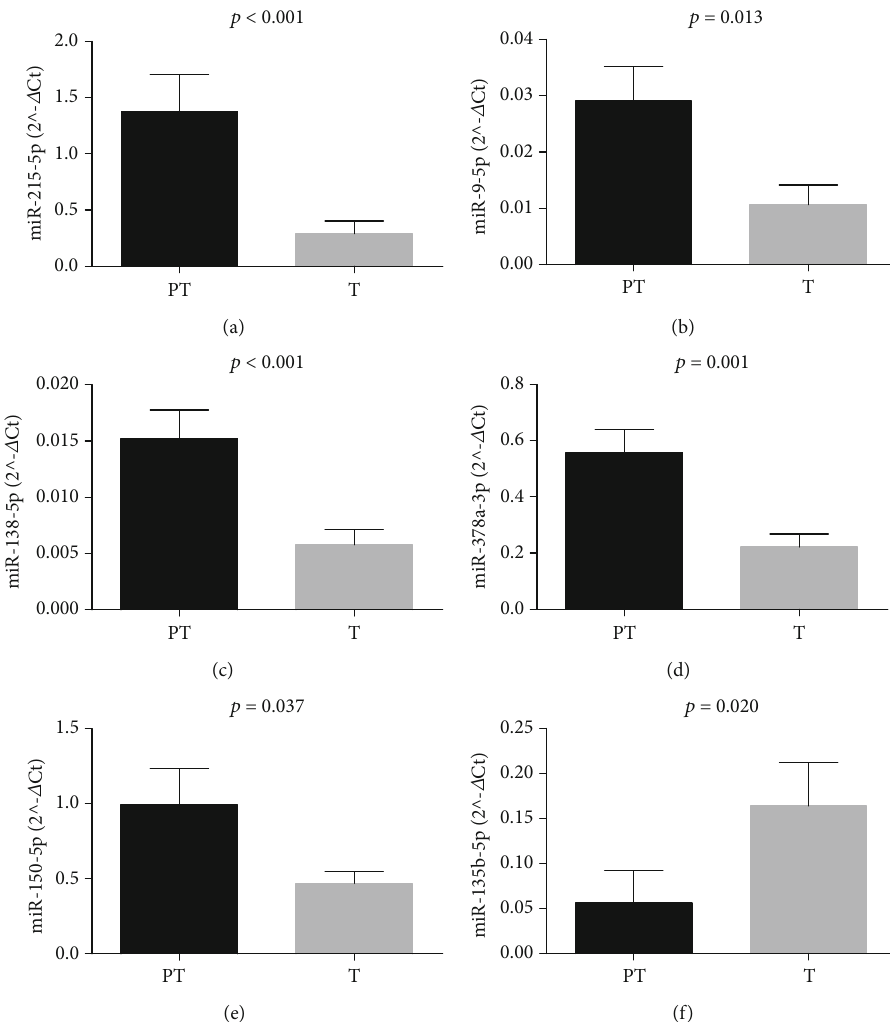
Figure 1: The graphs show the signi fi cant miRNAs di ff erentially expressed between tumoral and peritumoral tissues. Bar graphs represent the mean of the 2 − Δ Ct values, and error bars represent the standard error. p values have been calculated using the Mann – Whitney U test. (a) miR-215-5p; (b) miR-19-5p; (c) miR-138-5p; (d) miR-378a-5p; (e) miR-150-5p; (f) miR-135b-5p. PT: peritumoral; T: